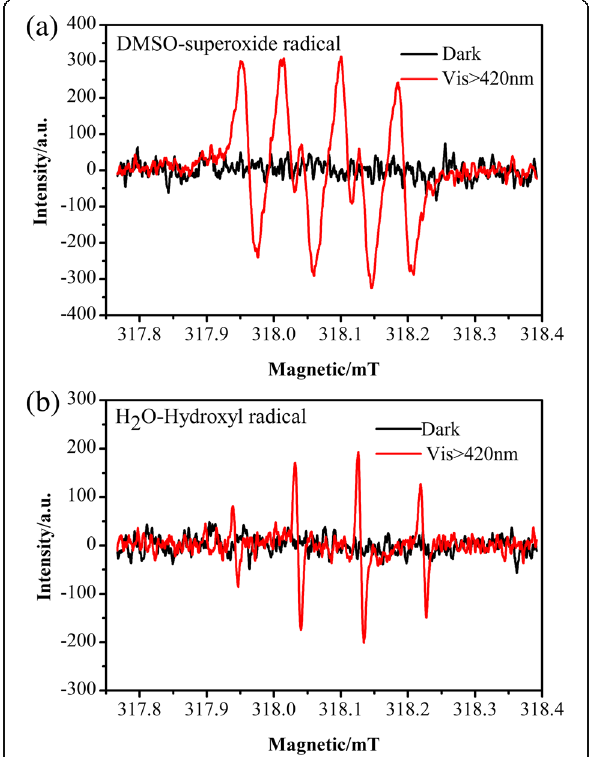
Fig. 12 Electron paramagnetic resonance (ESR) spectra of Ag/ BiV